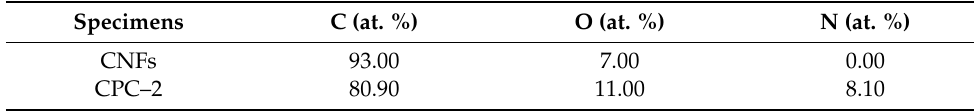
Figure 4. Optical microscope images of ( a 1 ) CNFs, ( b 1 ) CPC–2. SEM image of ( a 2 ) CNFs, ( b 2 ) CPC–2, TEM images of CNFs of ( a 3 , a 4 ), TEM images of CPC–2 of ( b 3 , b 4 ). Table 3. SEM line scanning of CNFs and CPC–2.